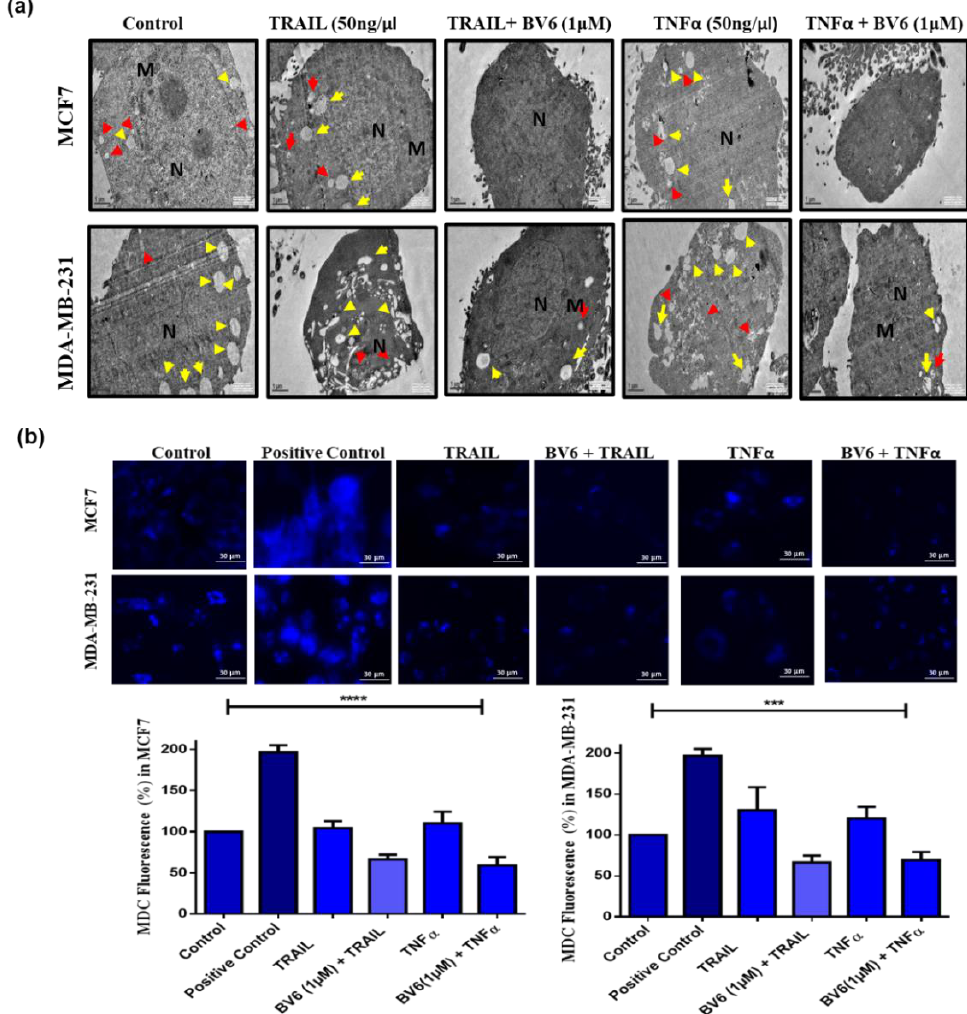
Figure 6. Autophagy in MCF7 and MDA-MB-231 cells treated with TRAIL (50 ng/mL), TNF α (50 ng/mL) and their combination with BV6 (1 µ M): ( a ) TEM images show a normal double-membrane nucleus surrounded with normal-appearing mitochondria along with accumulated autophagic vacuoles such as autophagosomes and autolysosomes. M represents mitochondria, N represents Nucleus ( b ) Fluorescence images captured from fluorescence microscopy of MDC staining showing stained autophagic vacuoles or autophagosome accumulation in untreated (control), starved cells (Positive control) and treated cells. Histogram profile representing the mean fluorescence intensity of TRAIL (50 ng/mL), TNF α (50 ng/mL) and their combination with BV6 (1 µ M) treated MCF7 and MDA-MB-231 compared to the fluorescent intensity of untreated control and positive control. Data represented is statistically significant: (***), and (****) show p ˂ 0.001, and p ˂ 0.0001, respectively, and is carried out in triplicates displayed as mean ± SEM.